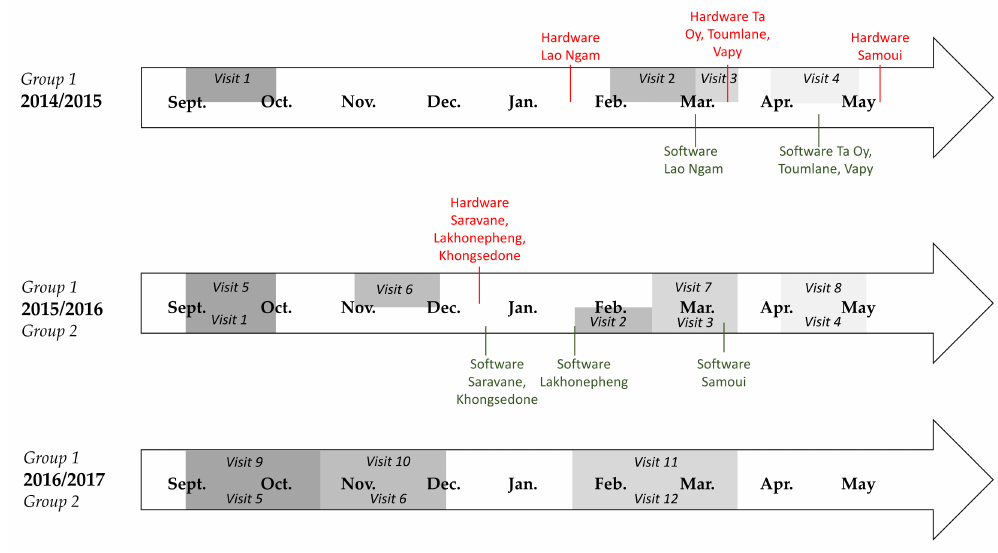
Figure 1. Project delivery and data collection visit